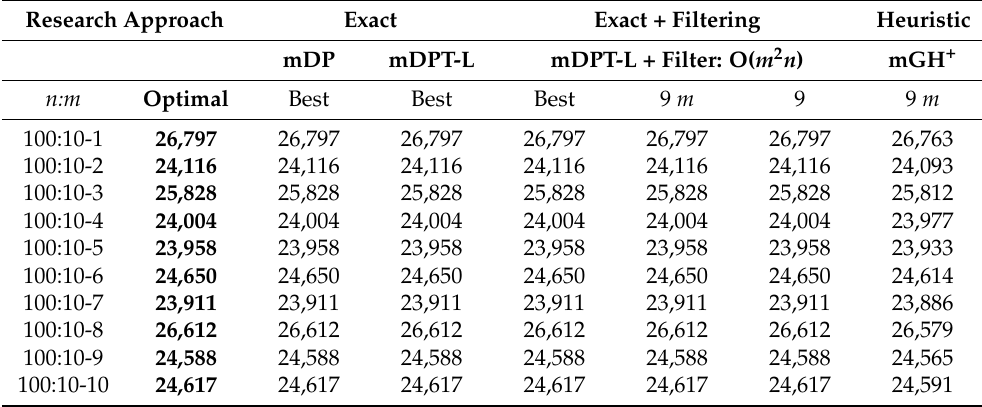
Table 12. Results (total profits) of 10 benchmark datasets ( n = 100, m = 10).